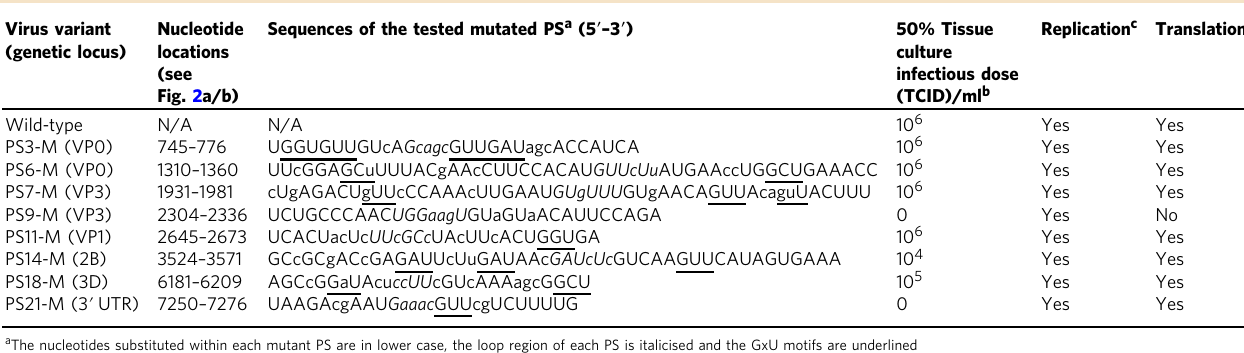
Table 2 PS mutants tested in cell culture and in vitro Virus variant Nucleotide (genetic locus)